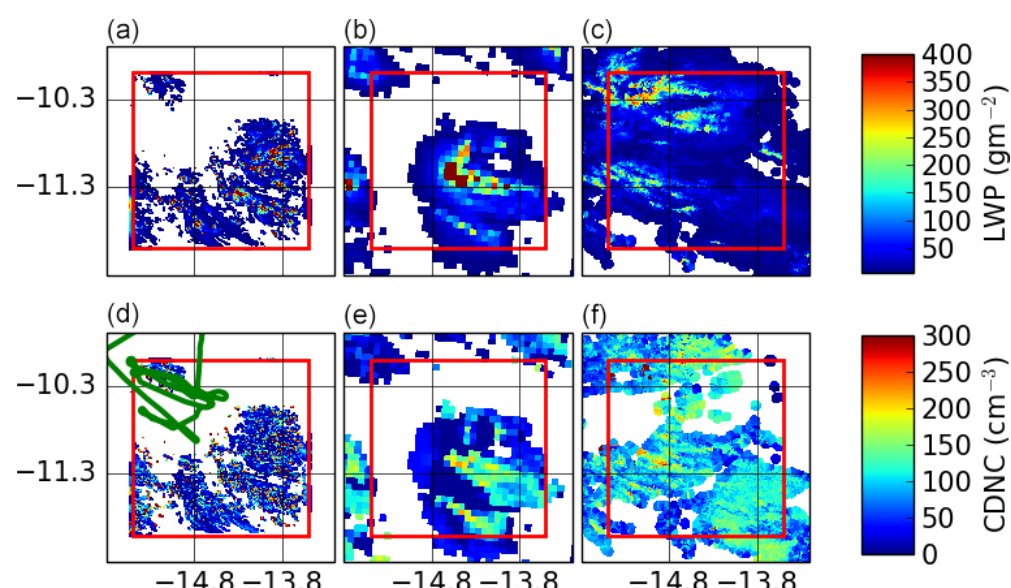
Figure 3. Liquid water path (LWP, a, b, c ) and cloud droplet number concentration (CDNC, d, e, f ) compared to MODIS on 19 August at midday. Instantaneous output from the 500m resolution simulation is shown in (a, d) , the 7km resolution simulation in (b, e) , and MODIS TERRA in (c, f) . The sizes of isolated MODIS pixels are increased during regridding for ease of viewing. There is not always a valid MODIS CDNC retrieval where there is a valid liquid water path, so the cloud extent can only be inferred from (c) . The green trace in (d) shows the path of the aircraft.